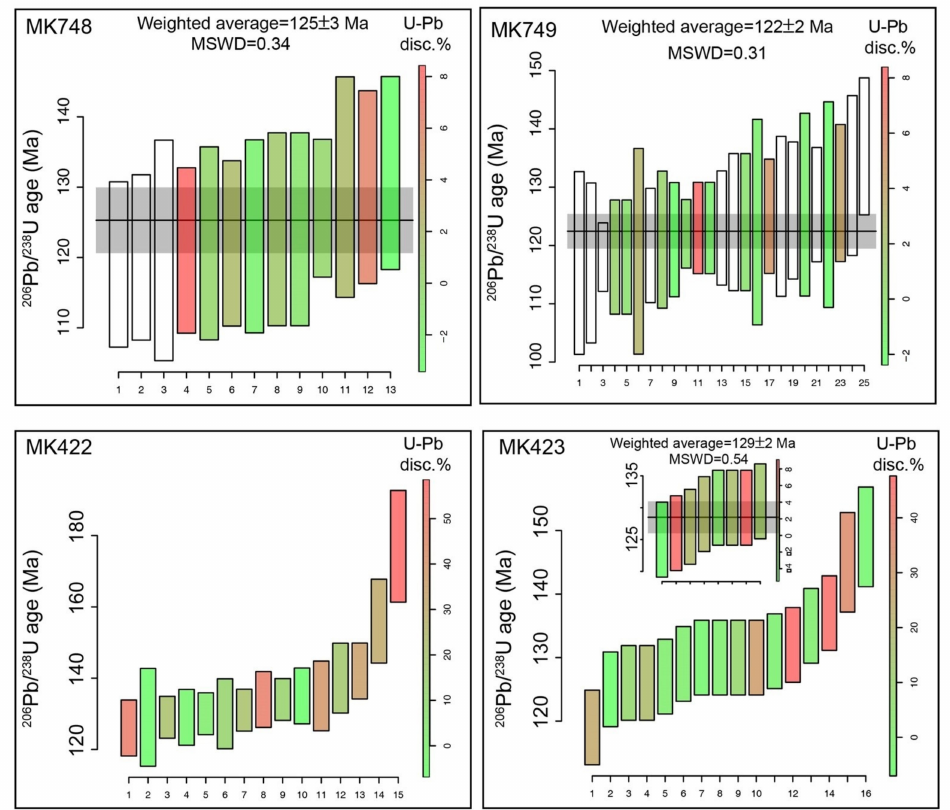
Figure 13. 206 Pb / 238 U age distribution of concordant and sub-concordant (discordance < ± 8%) data and discordant data (unfilled bars). The weighted average age and the relative Mean Square Weighted Deviates (MSWD) are also reported and refer only to filled